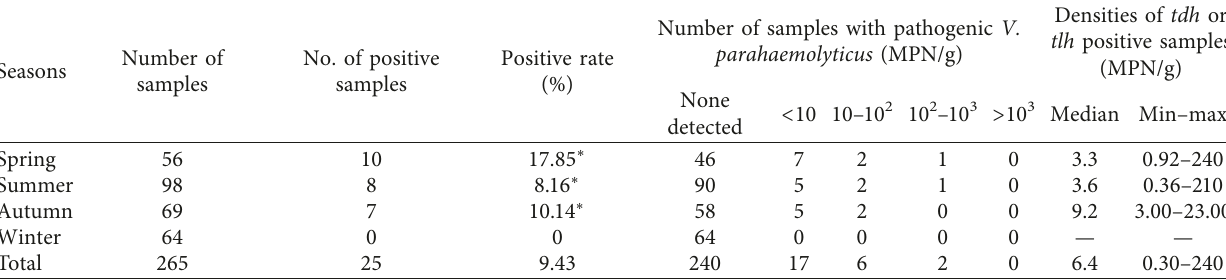
Table 6: Prevalence of contamination of pathogenic Vibrio parahaemolyticus in Anadara subcrenata in different markets. Number of Markets